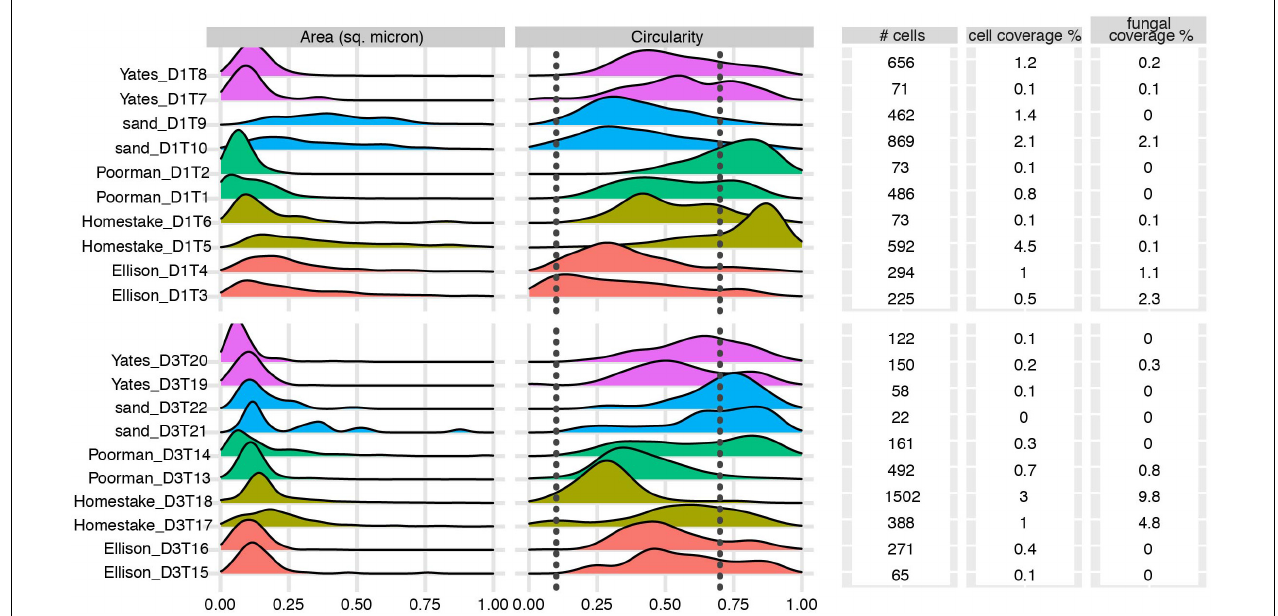
FIGURE 4 | Biofilm summary statistics: Cell area and circularity distributions, total number of observed cells, cell and fungal coverage over the transect area for each coupon. Sample IDs correspond to substrate type and coupon ID. Vertical dashed lines represent circularity thresholds for filaments, rods, and cocci (0-0.1, 0.1-0.7, and 0.7-1, respectively). X-axes are truncated at a maximum value of